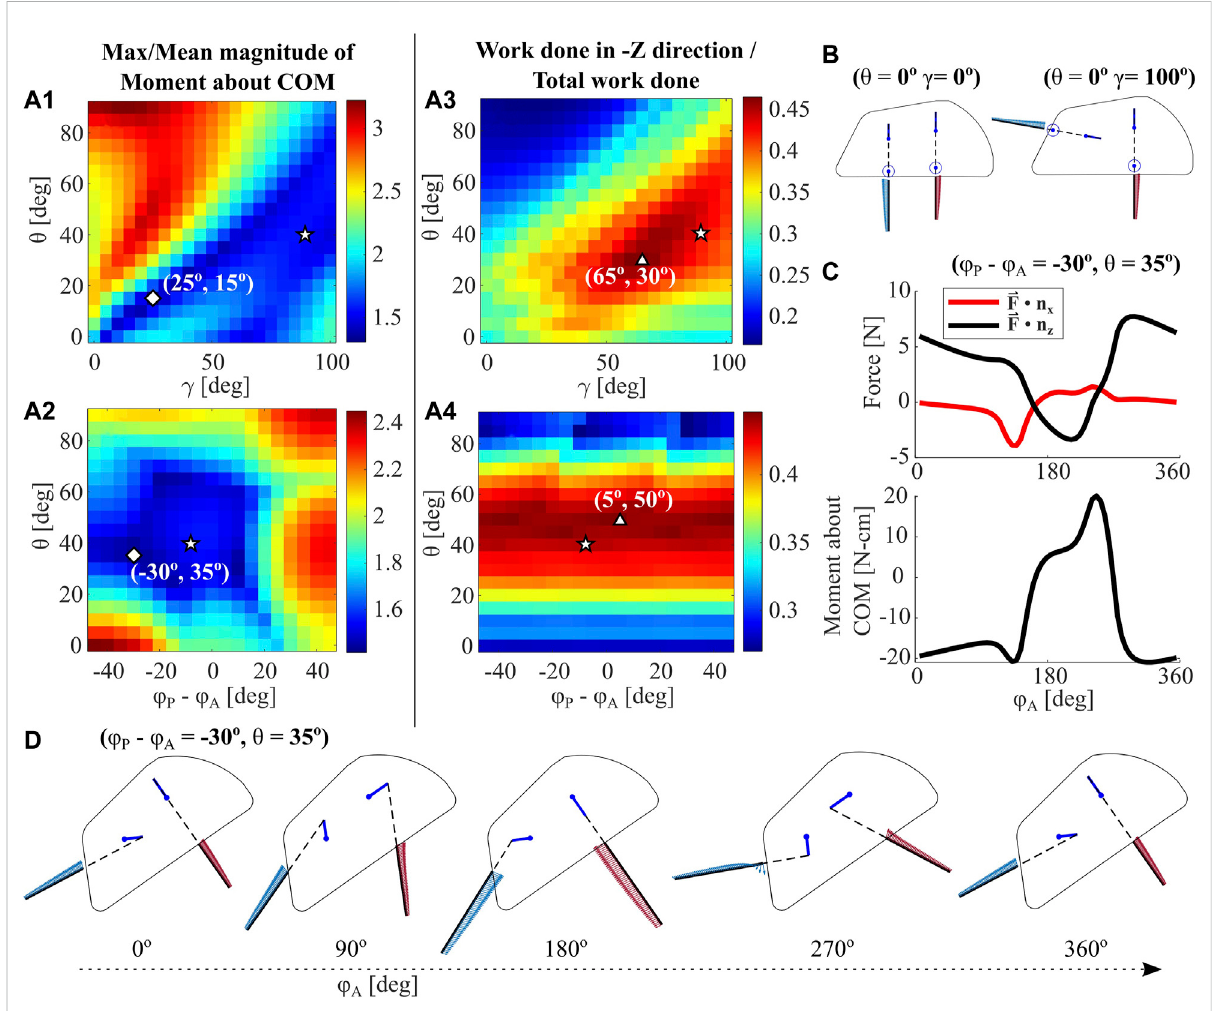
FIGURE 9 RFT Parametric Analysis. The RFT model for a single leg is used to analyze a 4-leg robot with varying body pitch θ , leg phase offset ϕ P − ϕ A , and offset in leg pose γ (A1-2) Maximum moment magnitude over entire leg cycle, normalized to mean moment magnitude for each trial, plotted over body pitch, phase, and γ . Diamonds represent model global minima, triangles represent model global maxima, and pentagrams represent the deepestrecorded burrowinexperiments (A3-4) Workdonewithcomponentsinthegravity(-Z)direction,normalizedtototalworkdoneovera leg cycle, plotted over body pitch, phase, and γ . Experimental initial conditions for the deepest measured burrow, as well as global maxima and minima,areindicated (B) Examplelegcon fi gurationsfortwovaluesof γ at θ =0 ° and ϕ =0 ° (C) TheRFT-predictedhorizontalandverticalforcesovera leg cycle, for the global minimum point indicated in (A2) (D) Depictions of robot shell, leg pose, and force distribution throughout a single leg cycle for the minimum point indicated in (A2)